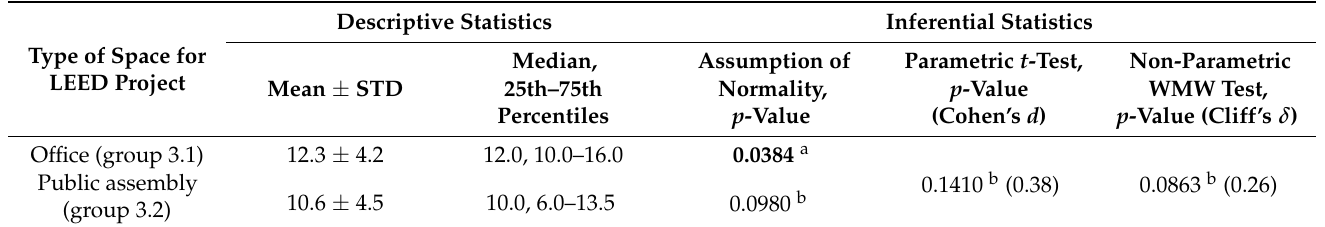
Table 7. Case 3: comparison of EAc7 (Optimize Energy Performance) credit achievement of groups 3.1 and 3.2 without considering project size in LEED-NC v4 silver projects.